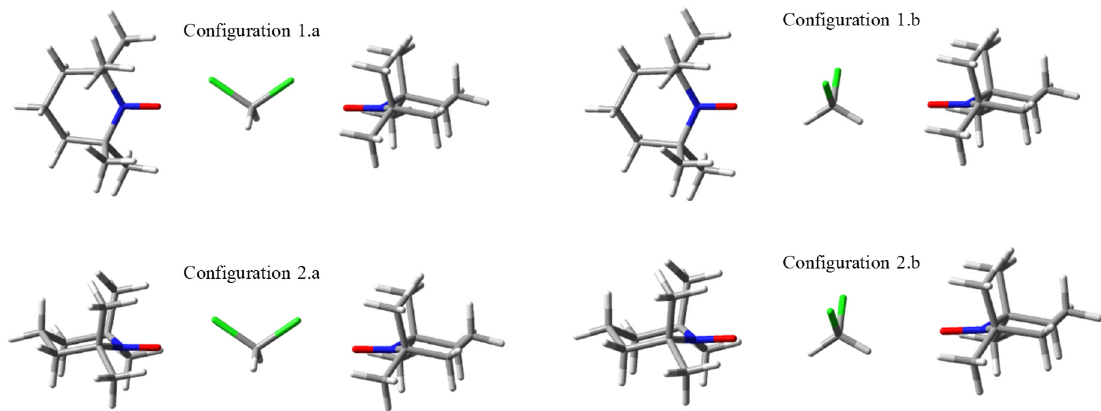
Figure 2. Scheme of molecular orientations in complexes including a dichloromethane molecule between two TEMPO radicals. The green color represents the chlorine atom and the other colors are the same as in the Figure 1.